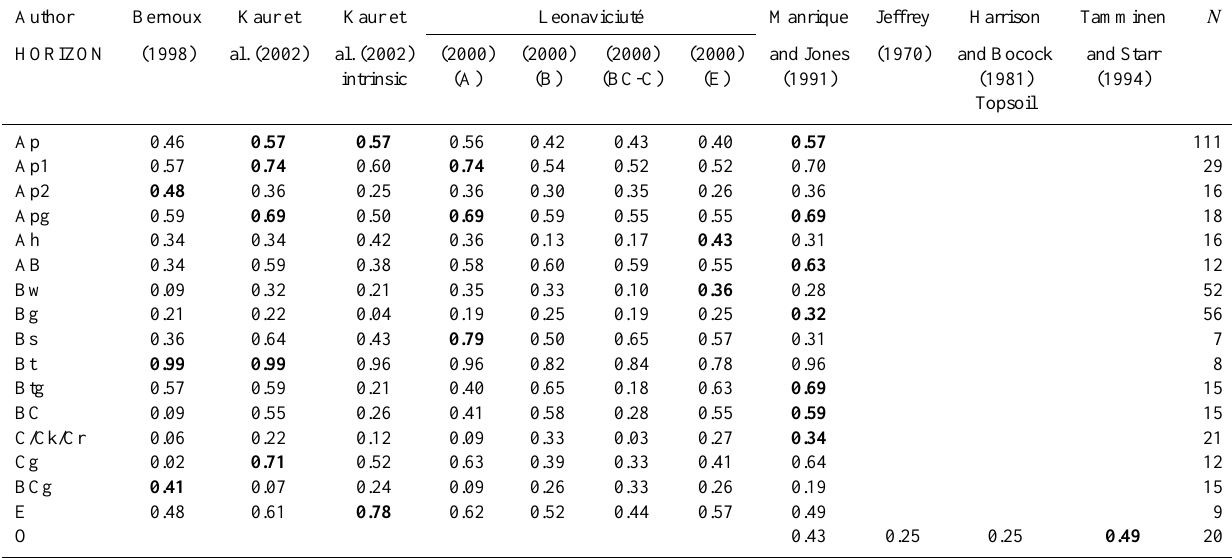
Table 4. Co-efficient of determination values ( R 2 ) when comparing original bulk density values to predicted values for each horizon type, using the listed pedotransfer functions. Bold indicates the highest R 2 value for a particular horizon type.